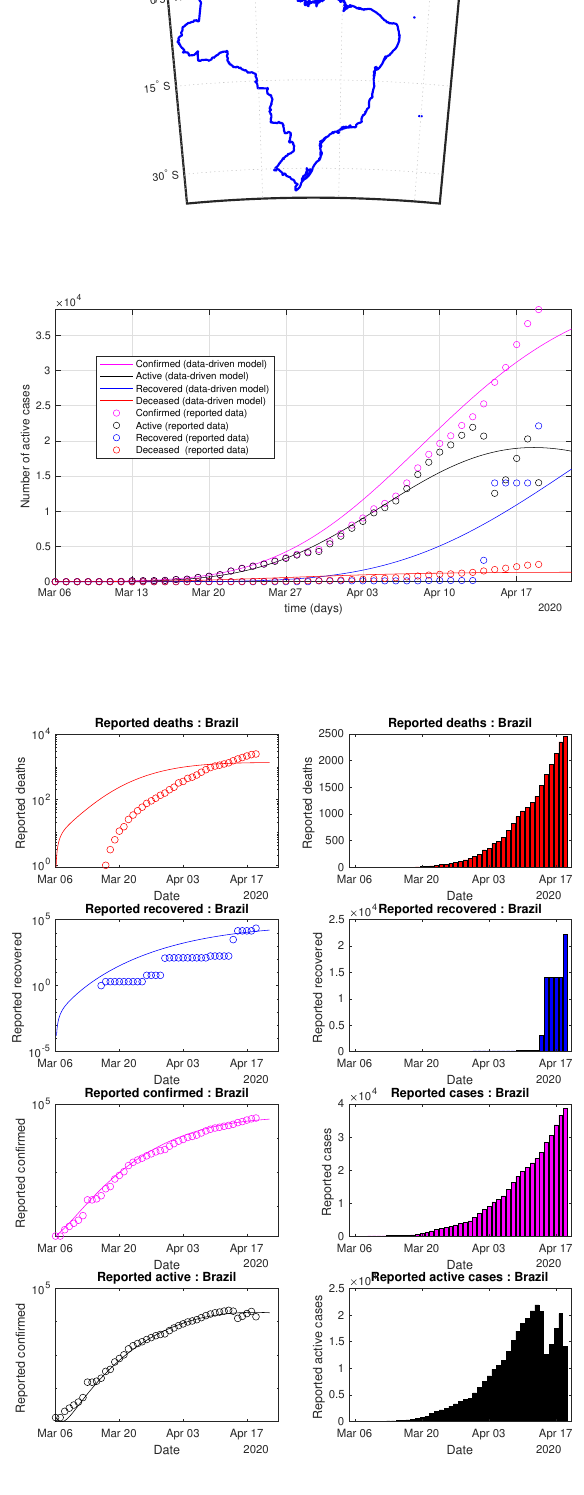
Figure 22. Brazil: data of active, recovered, deceased (in circle or bar) vs. model of active, recovered, deceased over time. Tracking the number of active cases. Predictive analytics for the next couple